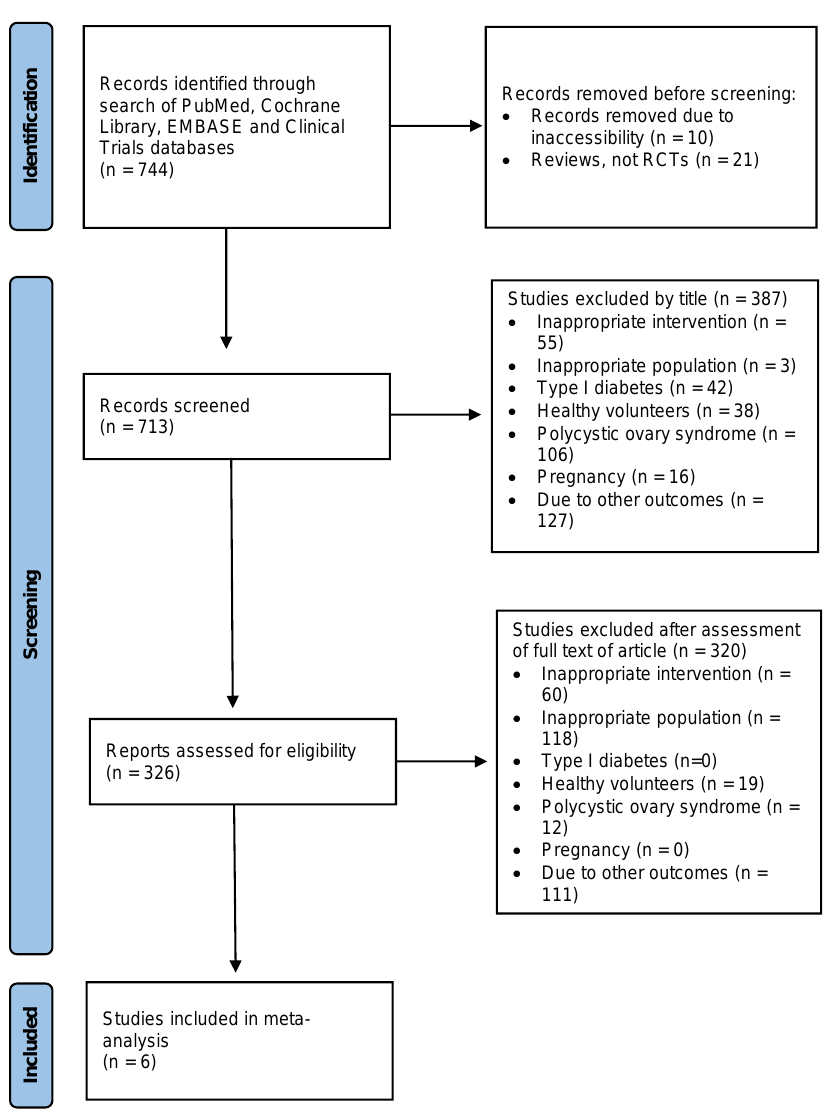
Figure 1. PRISMA flow diagram displaying results of the literature search .